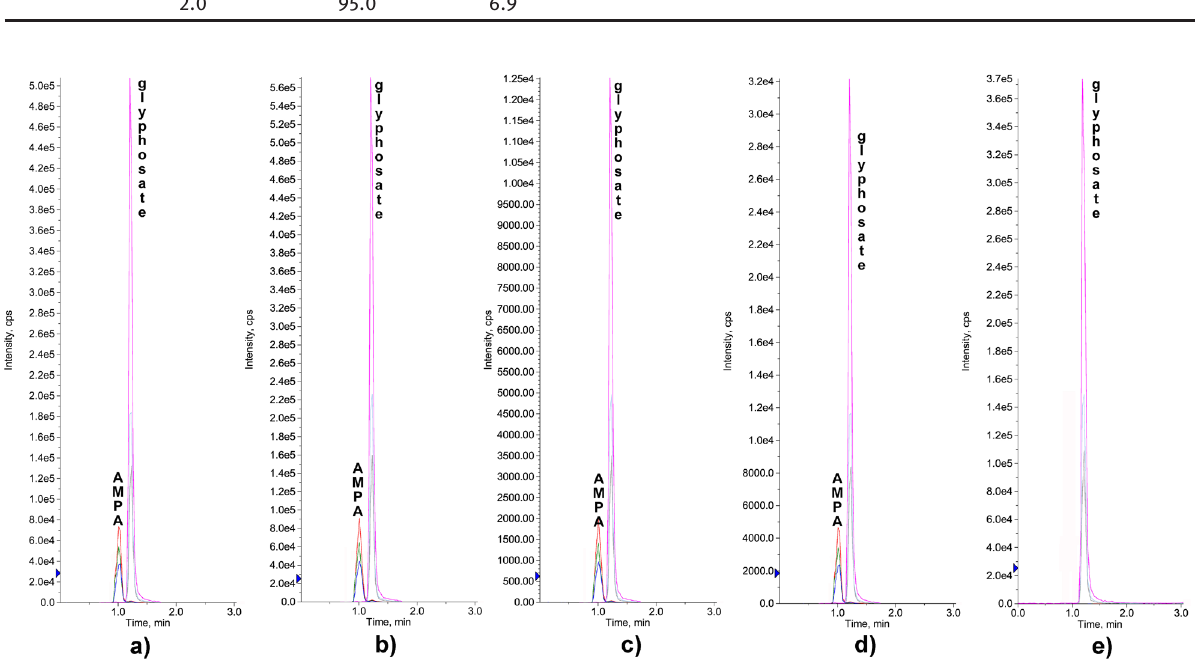
Figure 3: LC-MS/MS chromatograms of glyphosate and AMPA: standards 0.5 μg mL -1 in solvent (a), standards 0.5 μg mL -1 in matrix (b), standards 0.05 μg mL -1 in solvent (c), standards 0.05 μg mL -1 in matrix (d), PT sample